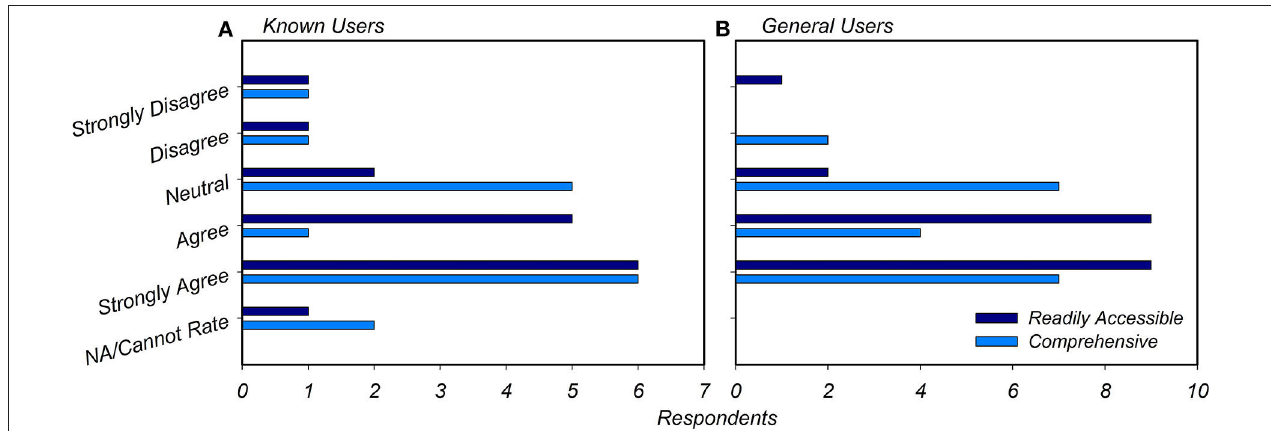
FIGURE 4 | Ratings of information of NHERI facilities and resources by user group. (A) is the known users, and (B) is the general users.